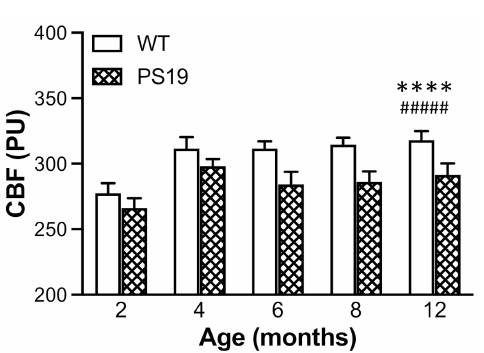
Figure 6. Mean ( ± SEM) resting cerebral blood flow (CBF) in the neocortex (presented as per- fusion unit, PU) of male wild-type (WT) and PS19 mice at 2, 4, 6, 8 and 12 months of age ( n = 11–15/genotype/age). **** indicates a significant genotype effect at p < 0.0001. ##### indicates a significant age effect at p <